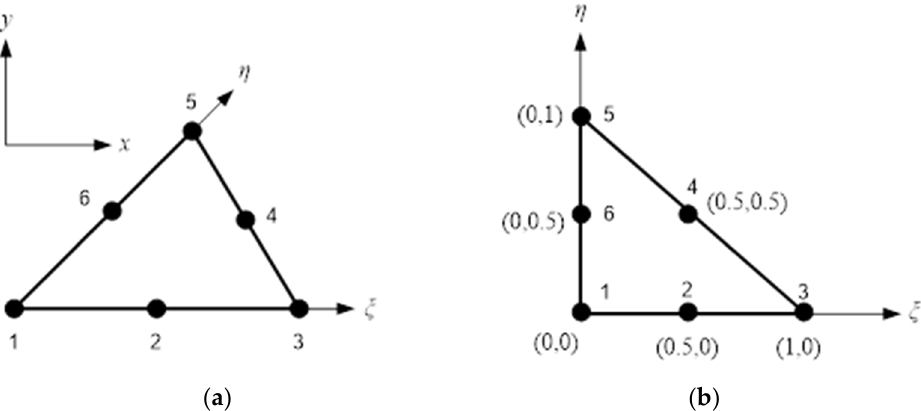
Figure 2. A quadratic triangle element in ( a ) global coordinates system and in ( b ) a natural coordinates system.